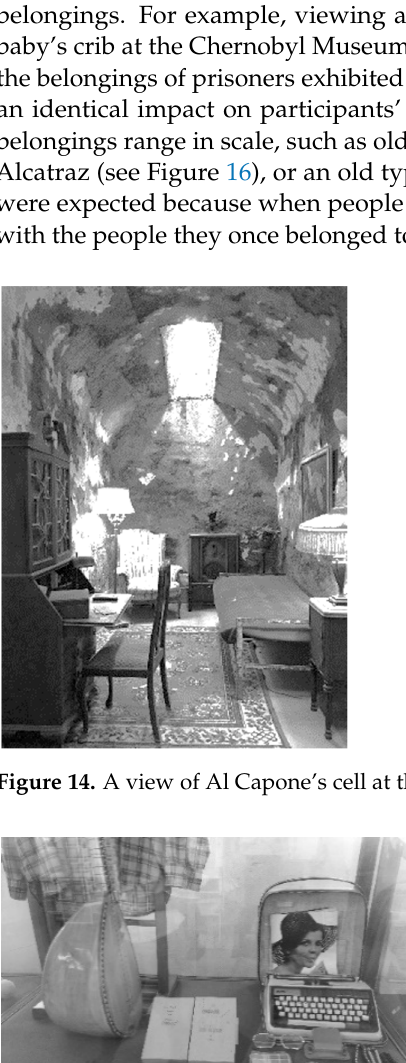
Figure 16. Musical instrument and artwork belongings at a cell inside Alcatraz. 4.2.4. Original Exhibit Well-preserved exhibits displayed in their original condition were found to be im- portant in maintaining a high level of engagement and surprise. Depending on the con- text, these exhibits may also trigger other types of emotion. Viewing children with birth defects at Chernobyl Museum, seeing burnt elevator cables at the 9/11 Memorial (see Figure 17), or experiencing fully furnished cells with triple bunk beds at the Sinop Prison Museum were all examples of exhibits that triggered multiple emotions such as fear, sadness, surprise and engagement. Figure 17. The burnt elevator motor cable at the 9/11 Memorial.